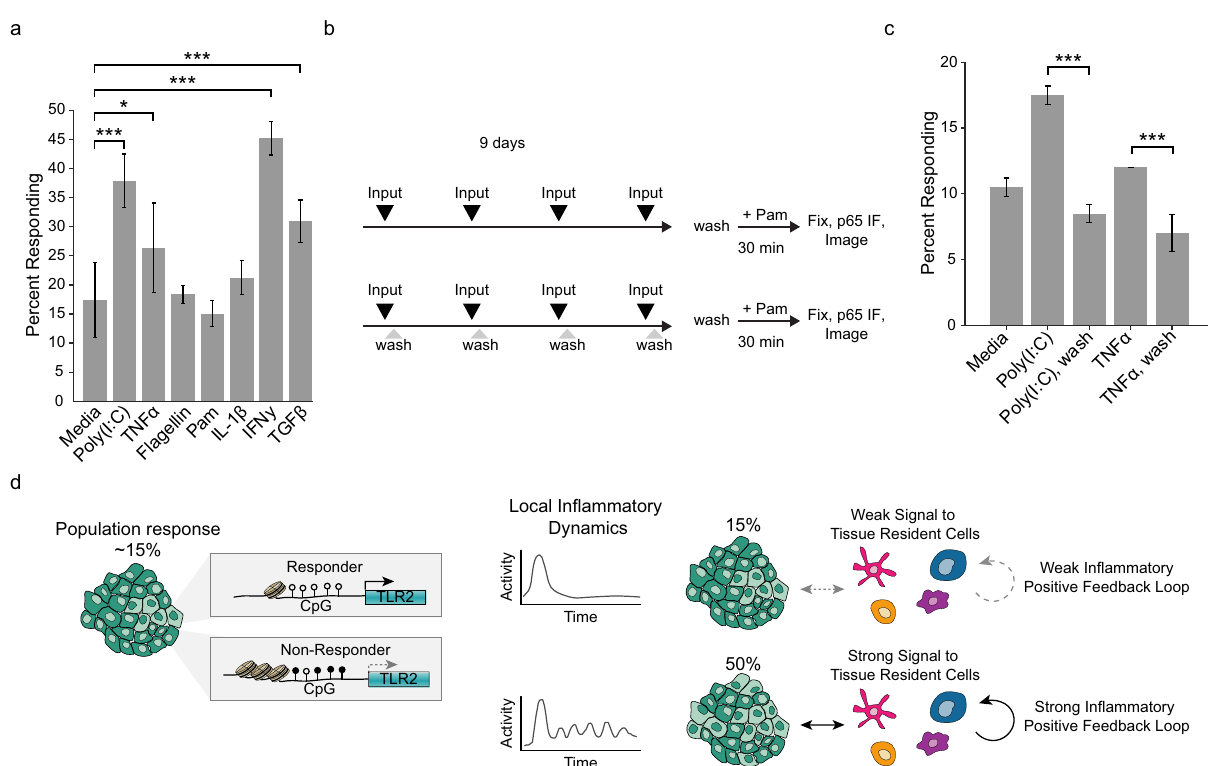
Fig. 7 High steady-state NF- ĸ B signaling increases the responder percentage. a WT monolayers were treated with indicated stimulus four times over a 9- day period. Concentrations of inputs were: Poly(I:C) 1 µ g/ml, TNF α 100ng/ml, Flagellin 1 µ g/ml, Pam3CSK4 1 µ g/ml, IL-1 β 100ng/ml, IFN γ 5 µ /ml, and TGF β 5 ng/ml. Error bars represent six technical replicates with n >1000 cells per replicate. Two-sample t test * p <0.05 and *** p <0.001. b Schematic